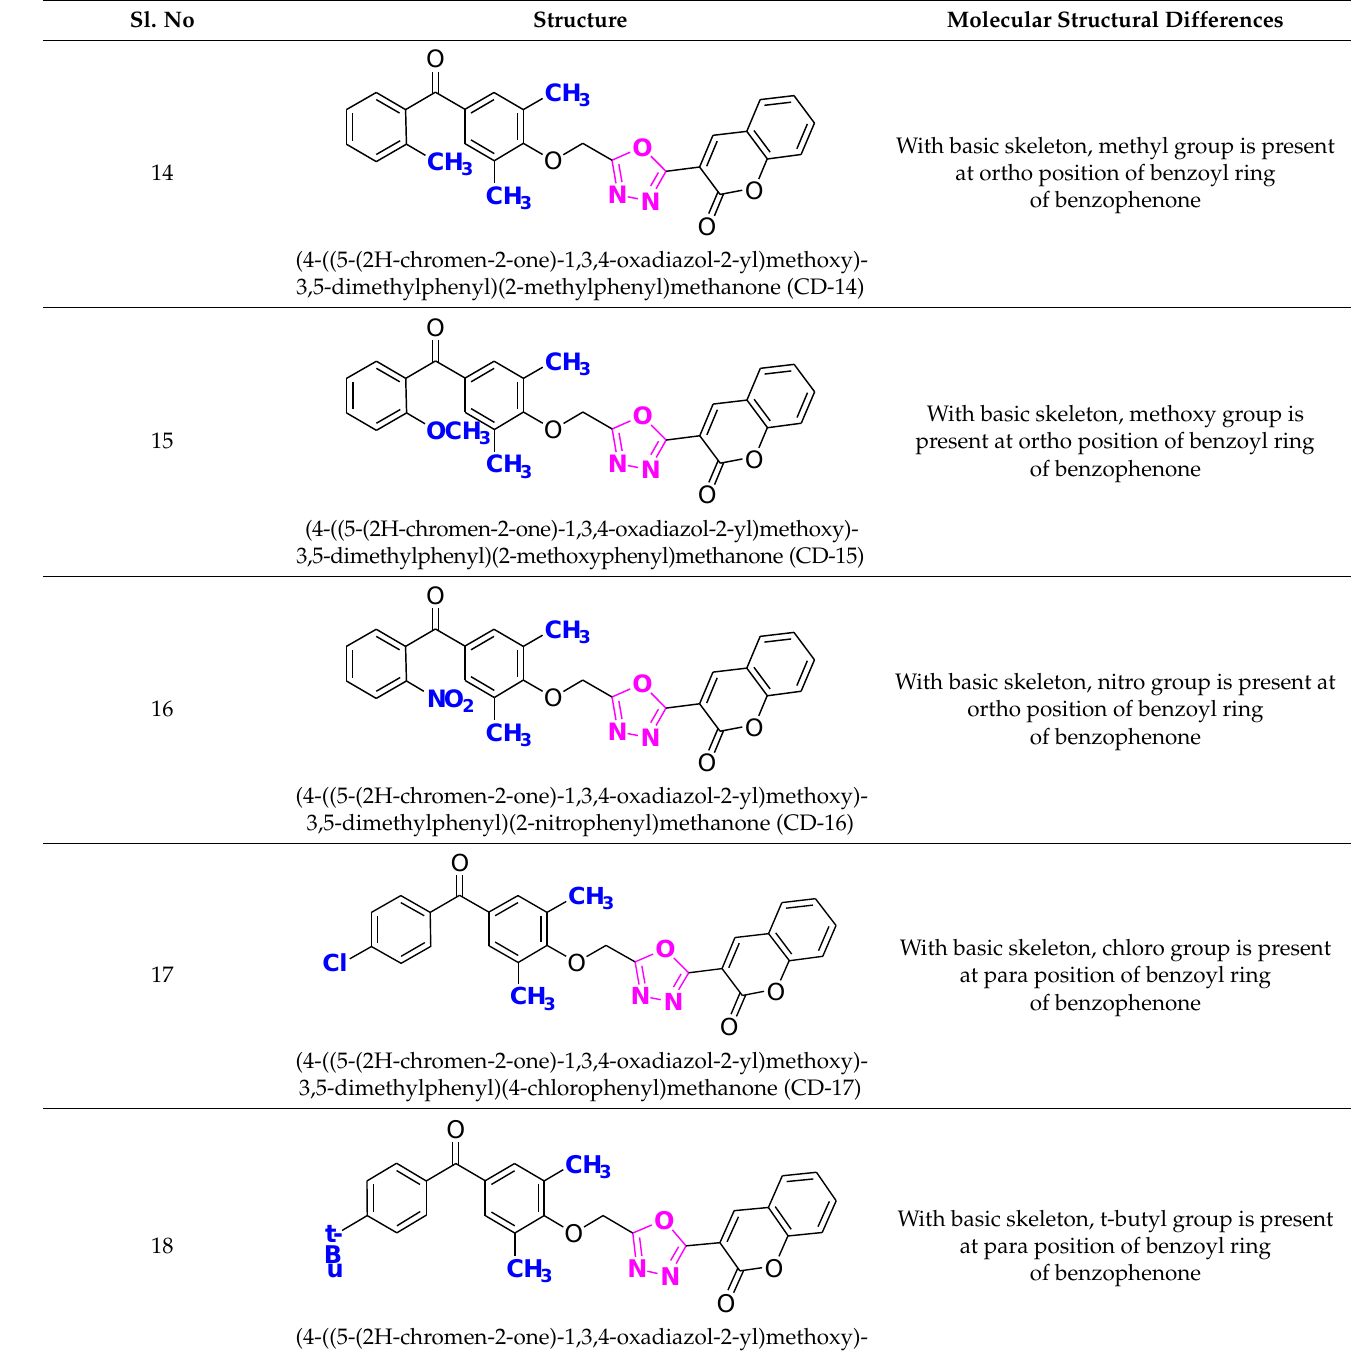
Table 1. Cont. Sl. No Structure Molecular Structural Differences